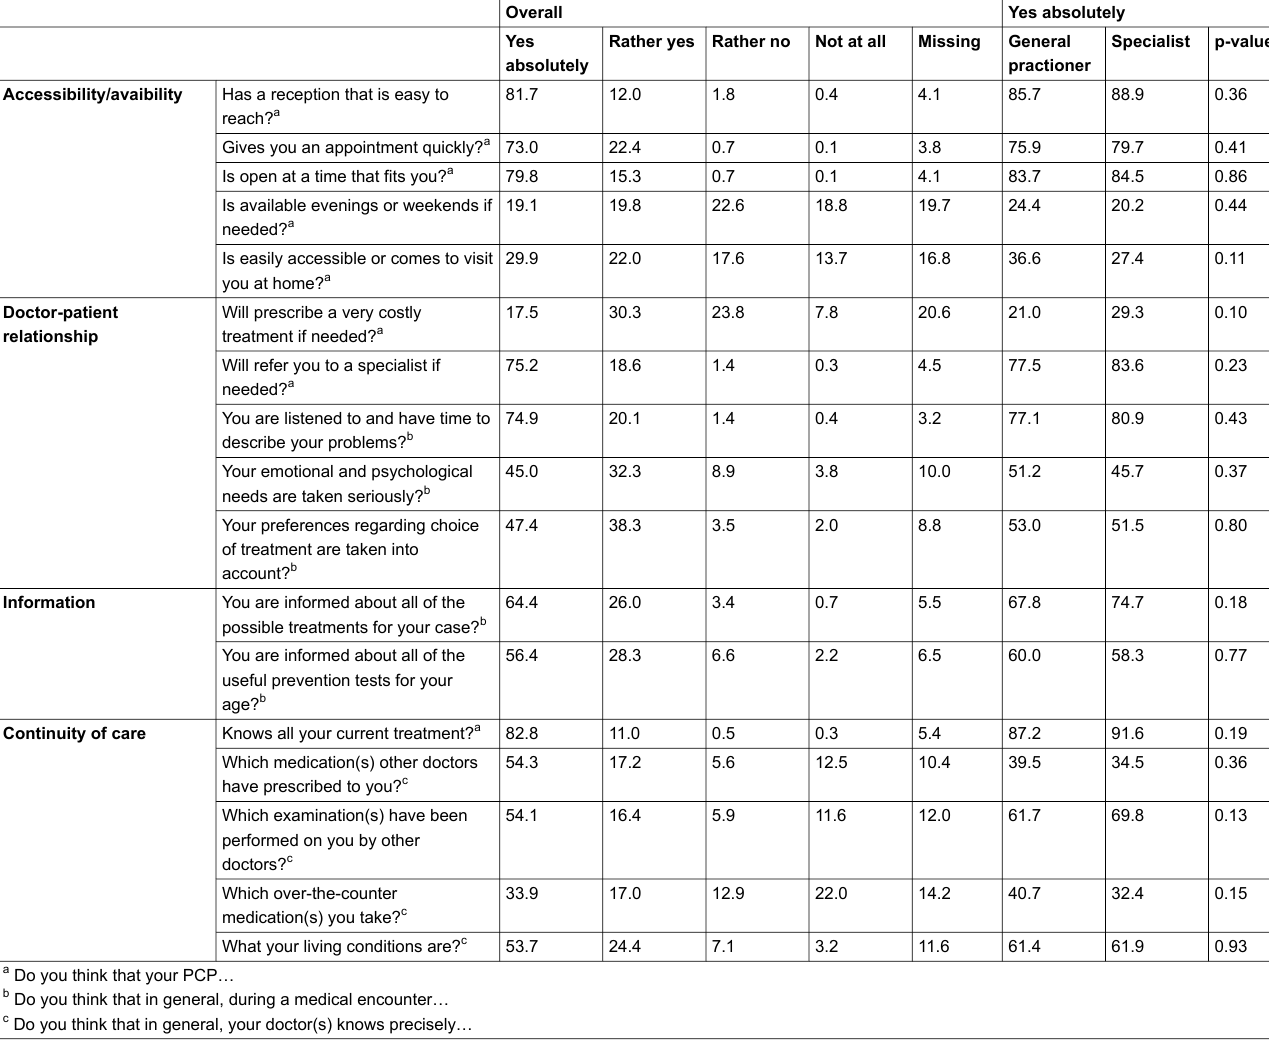
Table 2: Patients' perceptions of their primary care physicians, by type of primary care physician (all data presented as %).